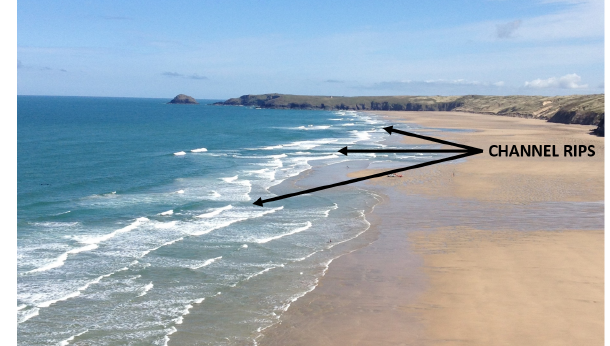
Figure 1. Channel rips typically present as darker corridors of water between the whiter patches of breaking waves, as shown here at Perranporth Beach, UK. The rips occur in deeper channels which reduce or prevent wave breaking, hence the darker visual signature. The rip channels often look like the calmest or safest place to swim to inexperienced observers. Image credit: